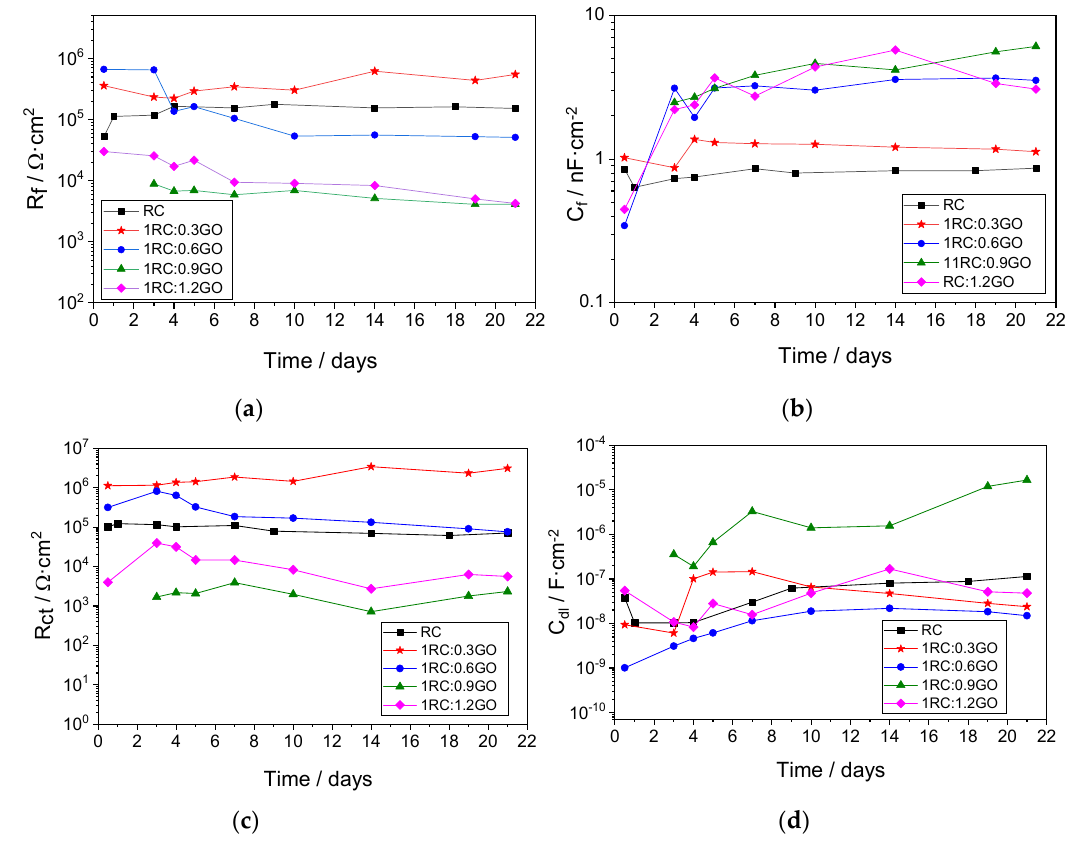
Figure 8. Evolution of the fitting parameters corresponding to the high-frequency time constant ( a ) R f and ( b ) C f , and to the middle frequency time constant ( c ) R ct and ( d ) C dl .